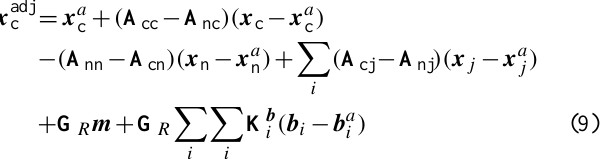
Figure 11: (Top) TES estimated methane at 562 hPa. (Bottom) TES estimated methane at approximately 500 hPa using an “information” averaging approach.